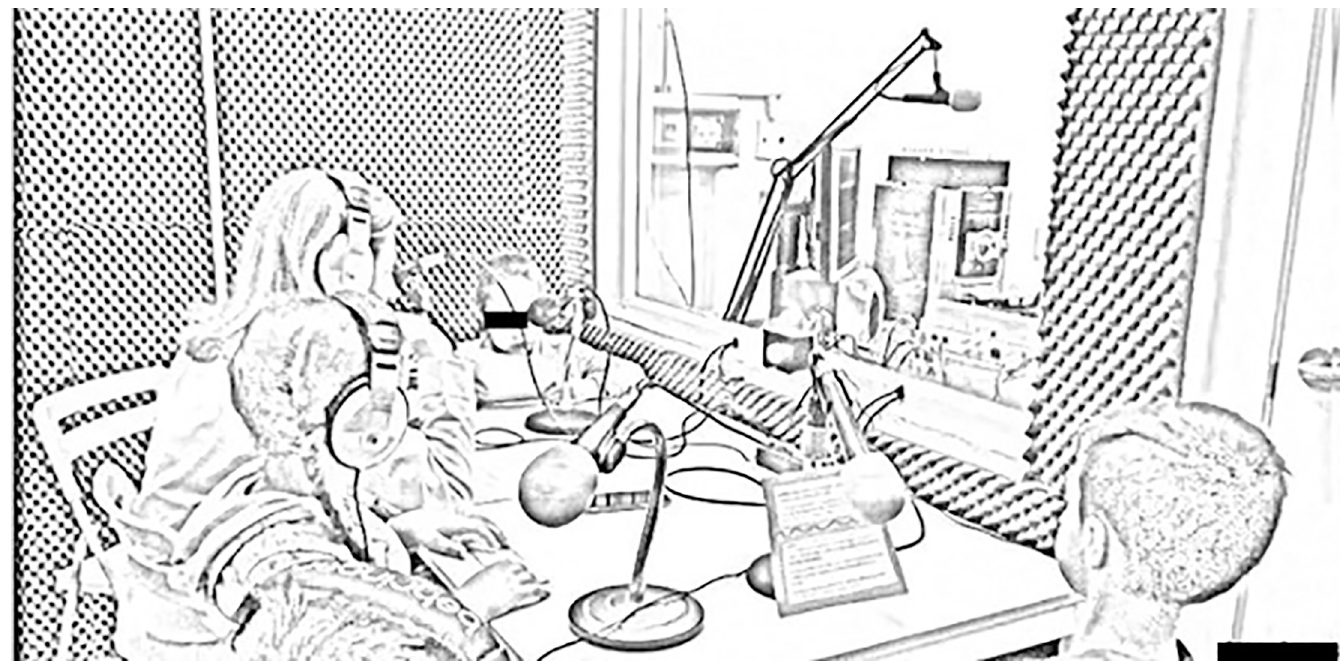
Fig 1. Photograph of the radio